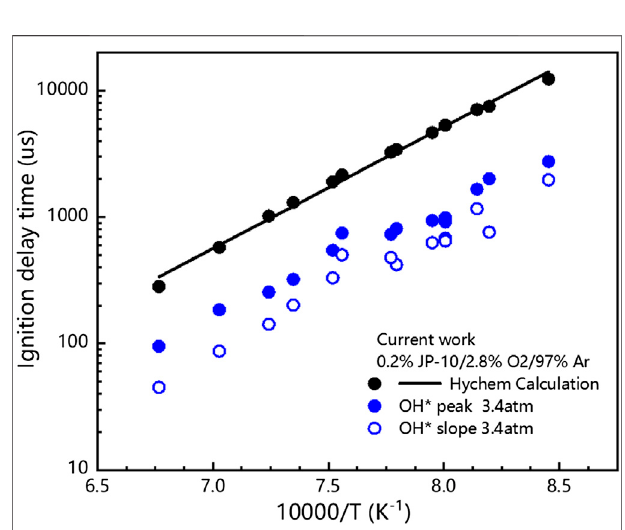
FIGURE9| Comparisonbetweenourmeasuredignitiondelaytimesand the calculated values with Hychem detailed mechanism.